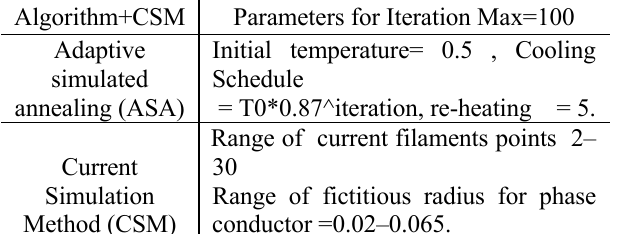
Table 1: Current Simulation Method and Adaptive Simulated Annealing Parameters.